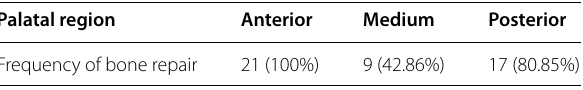
Table 4 Distribution of the regenerated areas of the midpalatal suture Palatal region Anterior Medium Posterior Frequency of bone